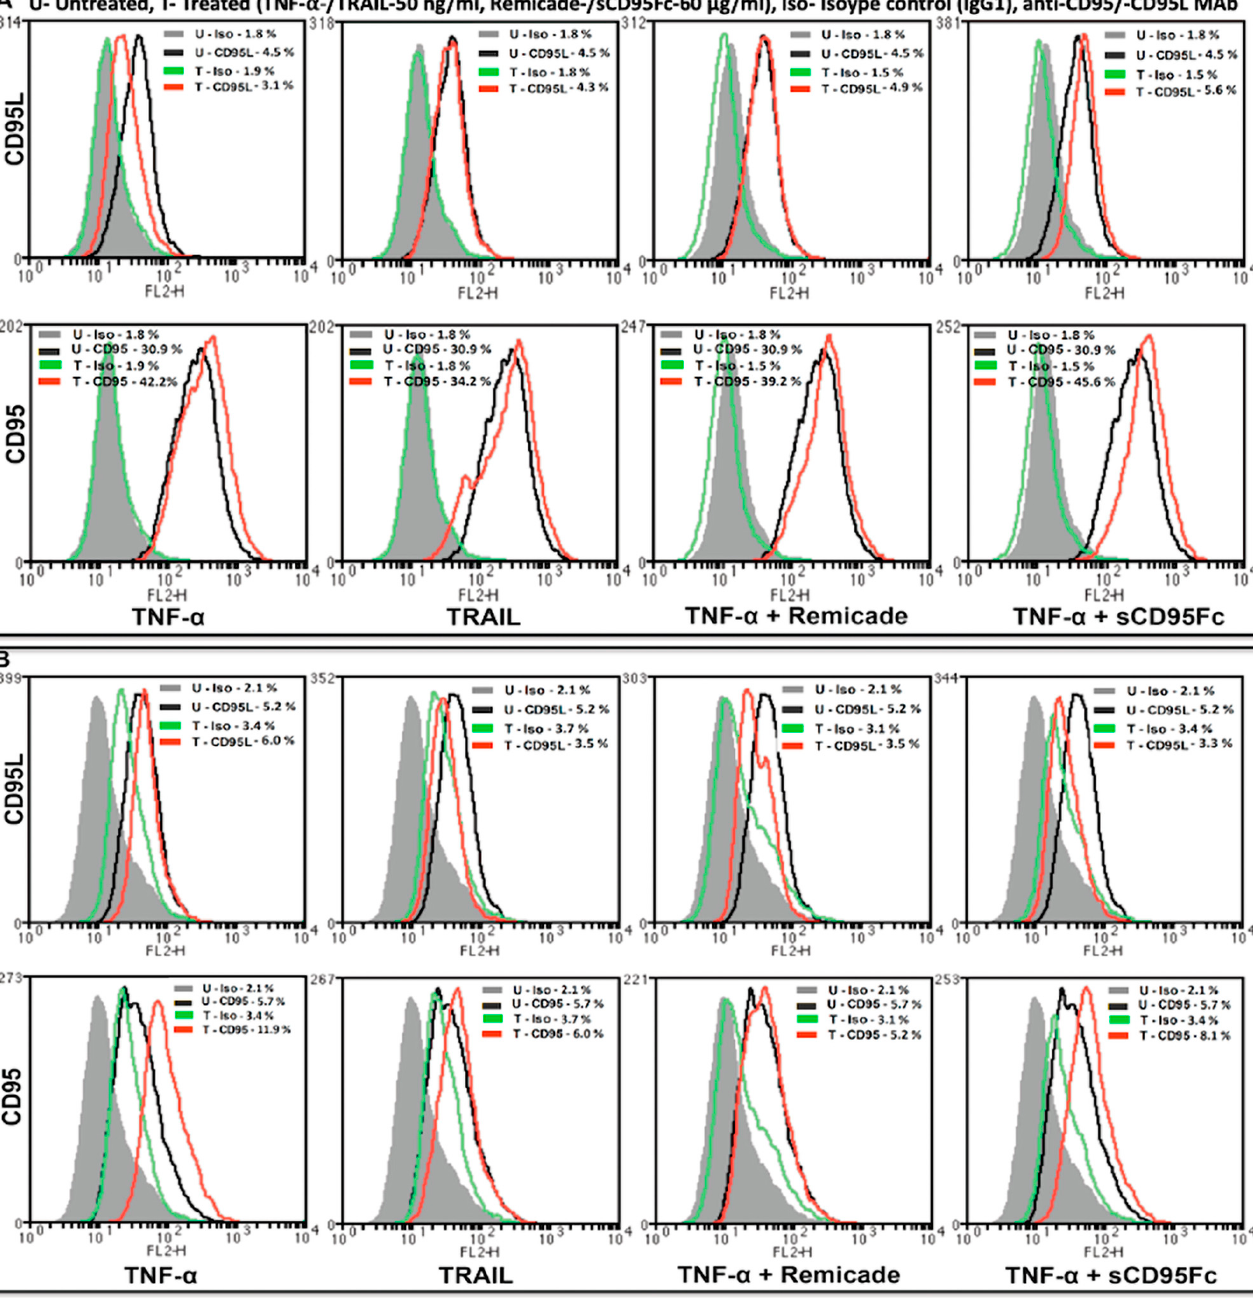
Figure 6. Analysis of PDAC cell-membrane-bound CD95L ( A , B upper row) and CD95 ( A , B lower row) protein expression by flow cytometry after treatment with TNF- α or TRAIL. CD95L and CD95 cell surface expression was assayed in non- permeabilized PancTuI-luc cells ( A ) and A818-4 cells ( B ) using phycoerythrin-conjugated mouse anti-human-CD95 antibody DX-2 or mouse anti-human-CD95L antibody NOK-1 (black line peaks -untreated and red line peaks -treated with TNF- α or TRAIL ± Remicade or sCD95Fc) or an irrelevant antibody (IgGl isotype control) used for the determination of background staining (grey filled peaks-untreated and green line peaks-treated with TNF- α or TRAIL ± Remicade or sCD95Fc). Raw data were analyzed and evaluated as histogram plots ( n = 2) as described in Section 2.